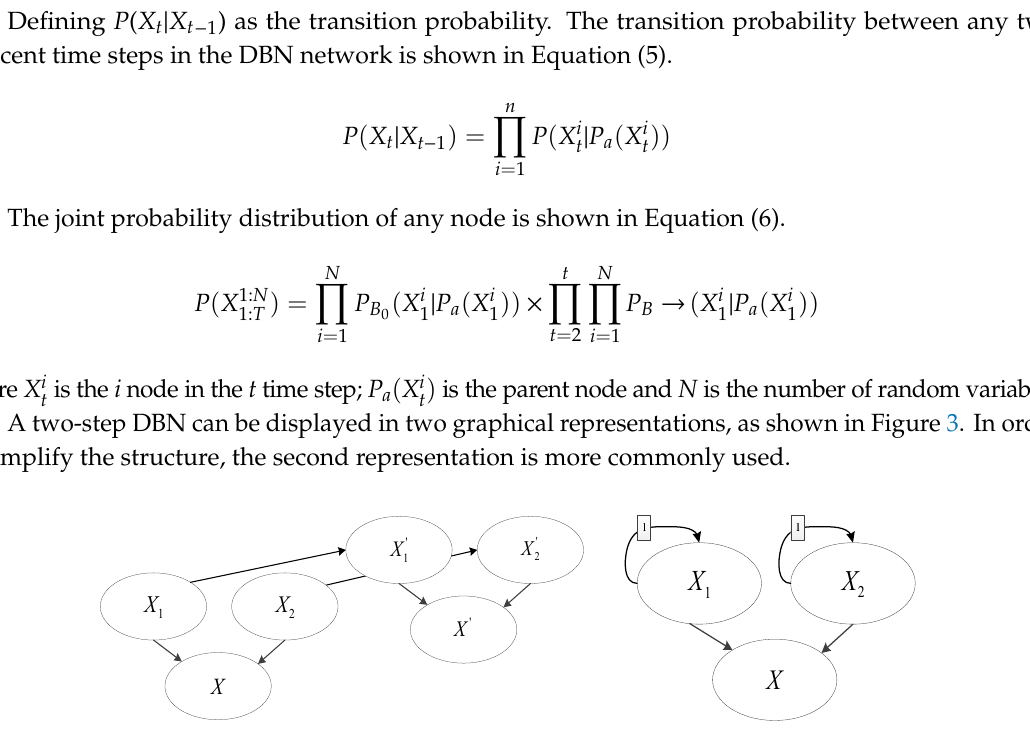
Figure 2. ( a ) Initial network B 0 of dynamic Bayesian network. ( b ) Transfer network of dynamic Bayesian network. ( c ) Expansion of the DBN on the time axis.